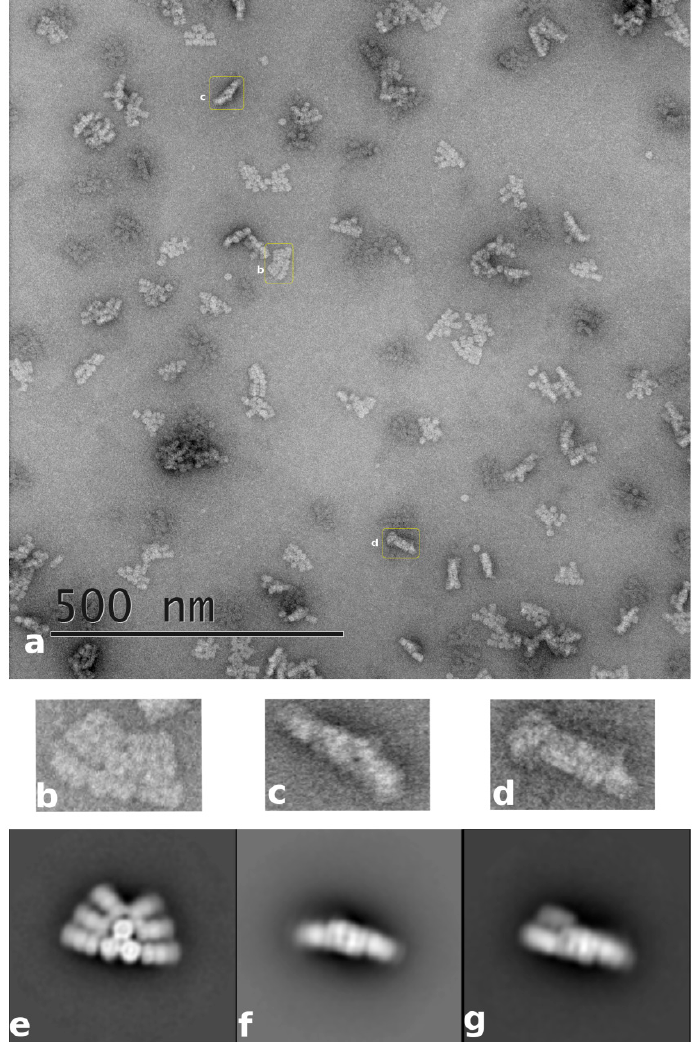
Figure 1. Structural compartmentalization of the phycobilisome from A. platensis : ( a ) Negative staining micrograph of the purified phycobilisome; ( b – d ) Inserts showing different views of the phycobilisome particle (from left to right: side, bottom, and oblique/inclined view); ( e – g ) Selected 2d class averages representing the same orientations (side -e, bottom -f, respectively oblique/inclined view -g).